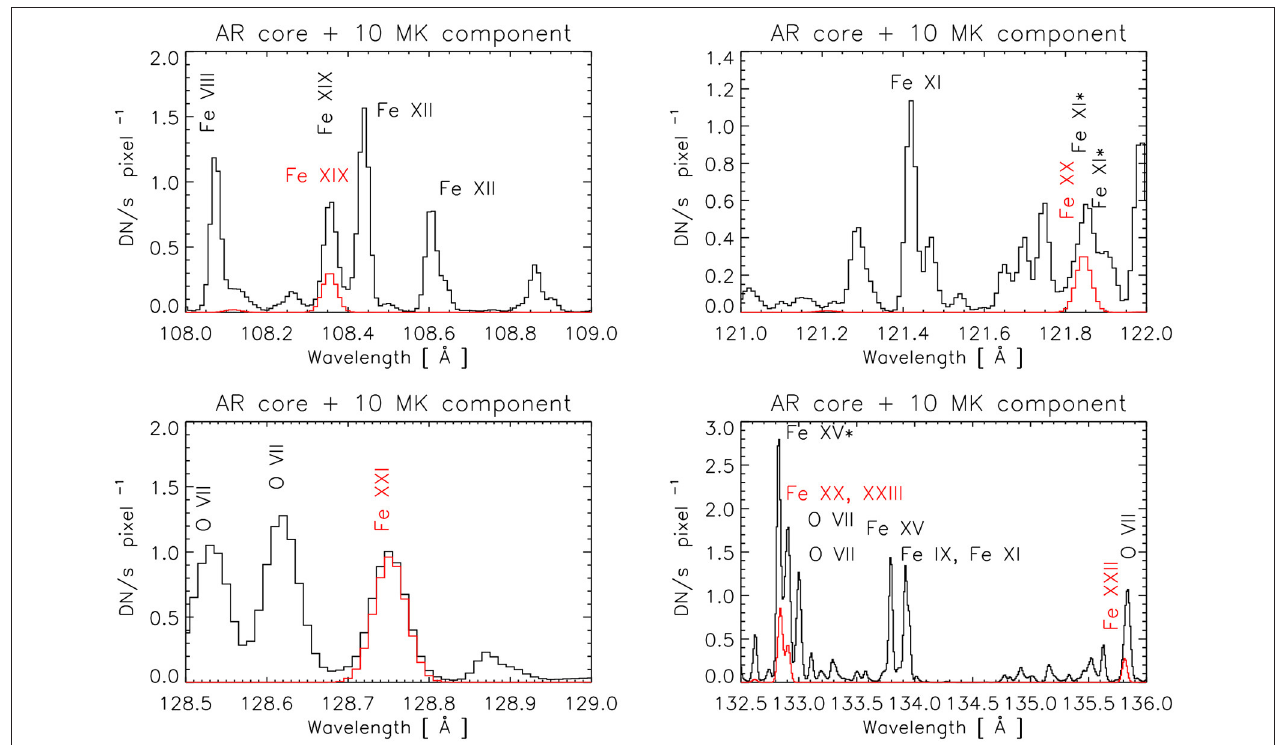
FIGURE 5 | Simulated count rates (1 ′′ pixel) for the emission from a very weak isothermal plasma at 10 MK (red spectrum), added to the emission from a quiescent active region core (black spectrum).